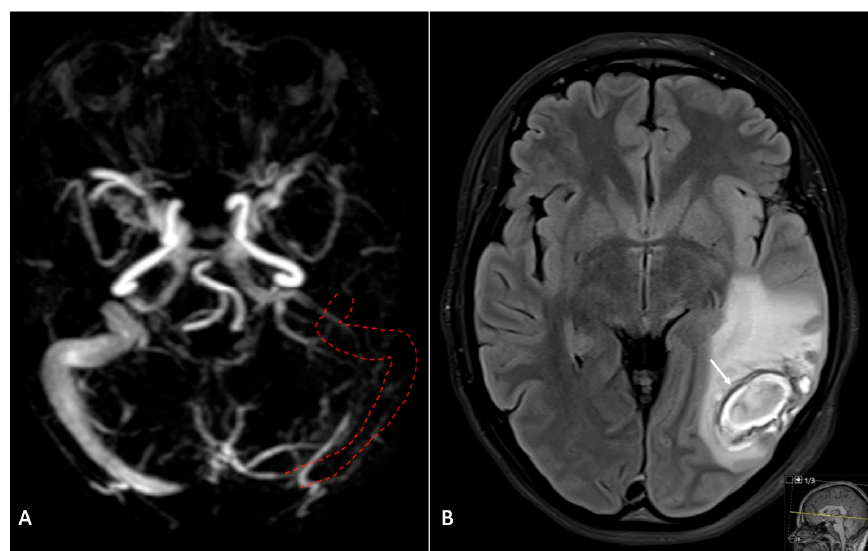
Figure 4. Representative MR images for sinus thrombosis. Pregnant woman with progressive left-sided headache due to sinus and vein thrombosis. Note the absence of the left transverse and sigmoid sinus (red dashed lines) on the MR angiography ( A ) causing parenchymal bleeding of the left temporal lobe (arrow), visible on the FLAIR image ( B ).